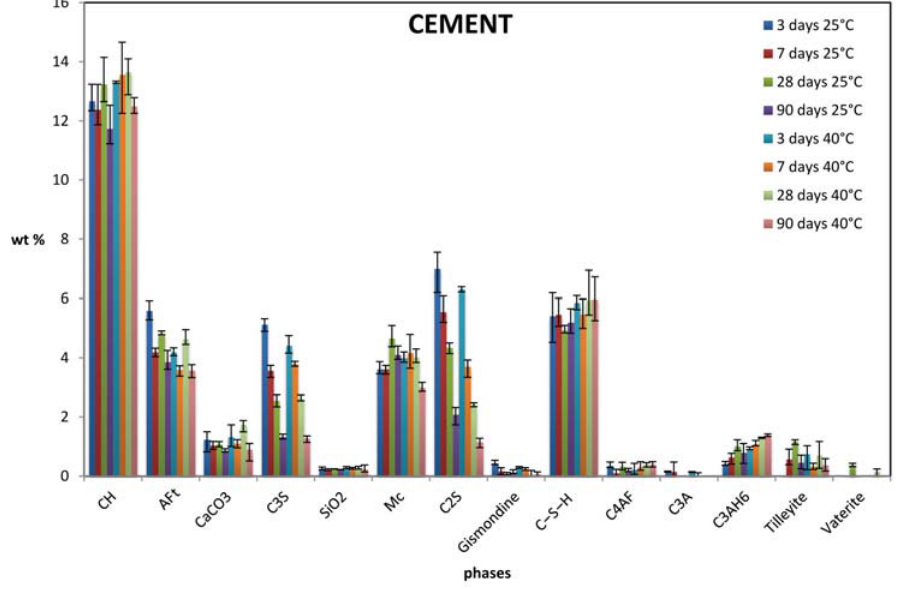
Figure 2. The quantitative analysis of cement hydration at 3, 7, 28 and 90 days of hydration and temperatures of 25 and 40